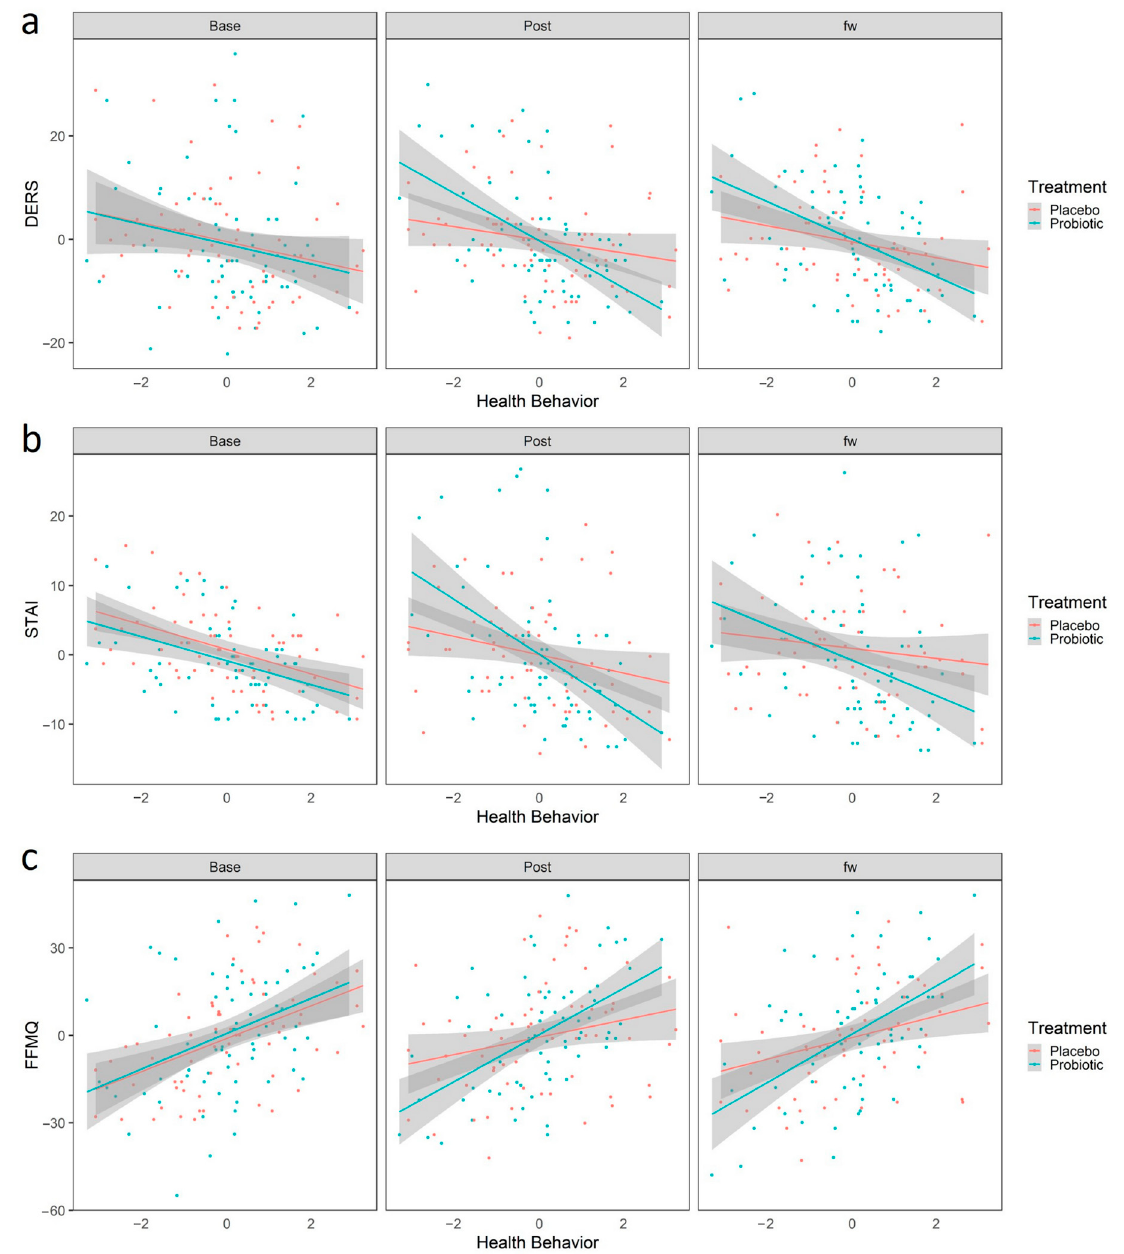
Figure 4. Linear Regression predicted scores using the linear regression model “Scales~Sex + Age + HB + Treatment+ HB × treatment + HB × treatment × time”. Red and blue colors represent placebo and probiotic groups, respectively. Points represent the values for DERS ( a ), STAI ( b ) and FFMQ ( c ). The shaded region represents the standard error. Abbreviations: STAI, State Trait Anxiety Inventory; DERS, Difficulties in Emotional Regulation Scale; FFMQ, Five Facet Mindfulness Questionnaire; HB, Healthy Behaviors.